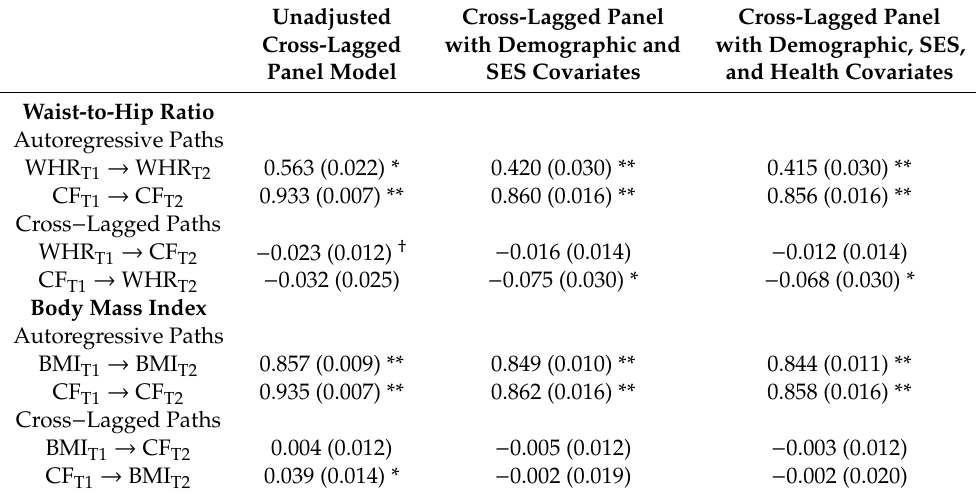
Table 5. Standardized autoregressive and cross-lagged paths coe ffi cients of obesity (waist-to-hip ratio and BMI) and the latent variables of global cognitive